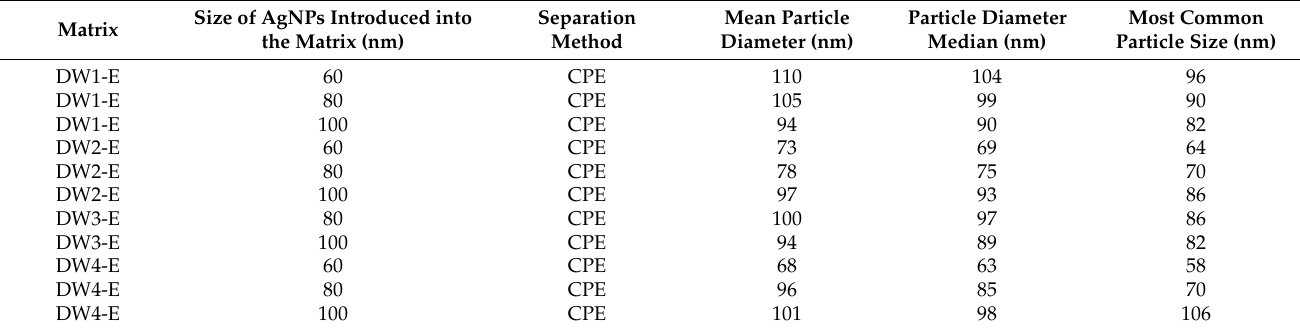
Table 6. Results of AgNP separation after extraction in the cloud point obtained for drilling waste extract samples DW(1–4)-E with AgNP addition of different sizes (60 nm, 80 nm, and 100 nm). The table contains values obtained for the mean particle diameter, particle diameter median, and most common particle size.